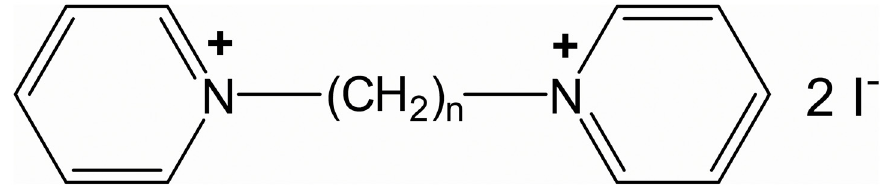
Fig 1. Molecular structure of the bispyridinium compounds